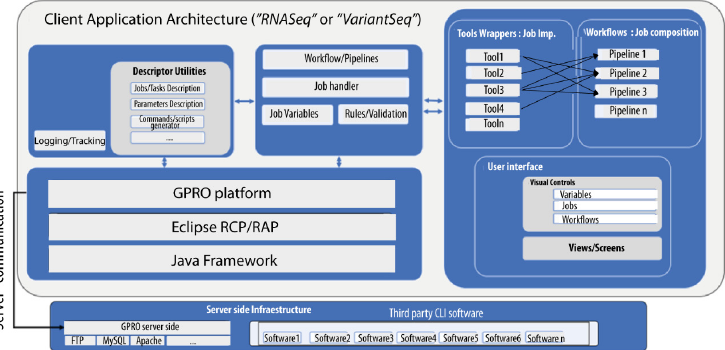
Figure 1. Client-side and server-side schematic and implementation. “ RNASeq ” and “ VariantSeq ” were both implemented using a common eclipse framework that enables encapsulation of third-party CLI tools as task wrappers, dynamically generated GUI views for each CLI tool, executable scripts, composable pipelines, and tracking/logging outputs of running jobs. The GSS provides the Linux environment and all other server requirements to run the CLI software (including scripts, R, Perl, Python, and MySQL server). Applications and the GSS connect via